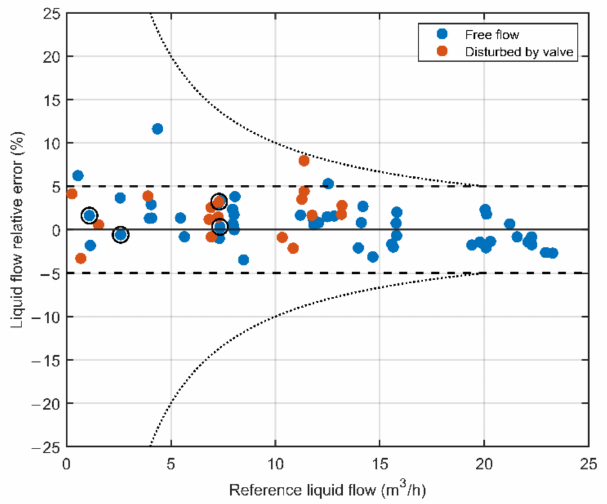
Figure 7. The relative liquid flow rate error as a function of reference liquid flow rate for all multiphase flow experiments that were presented in Figure 4. The dashed lines represent a ± 5% error band that is the generally accepted liquid flow rate accuracy required in multiphase flow metering. The dotted lines represent the relative error that corresponds to a zero-point inaccuracy of ± 1 m 3 /h that is commonly accepted as a practical limit for the accuracy of multiphase flow metering systems at low liquid flow